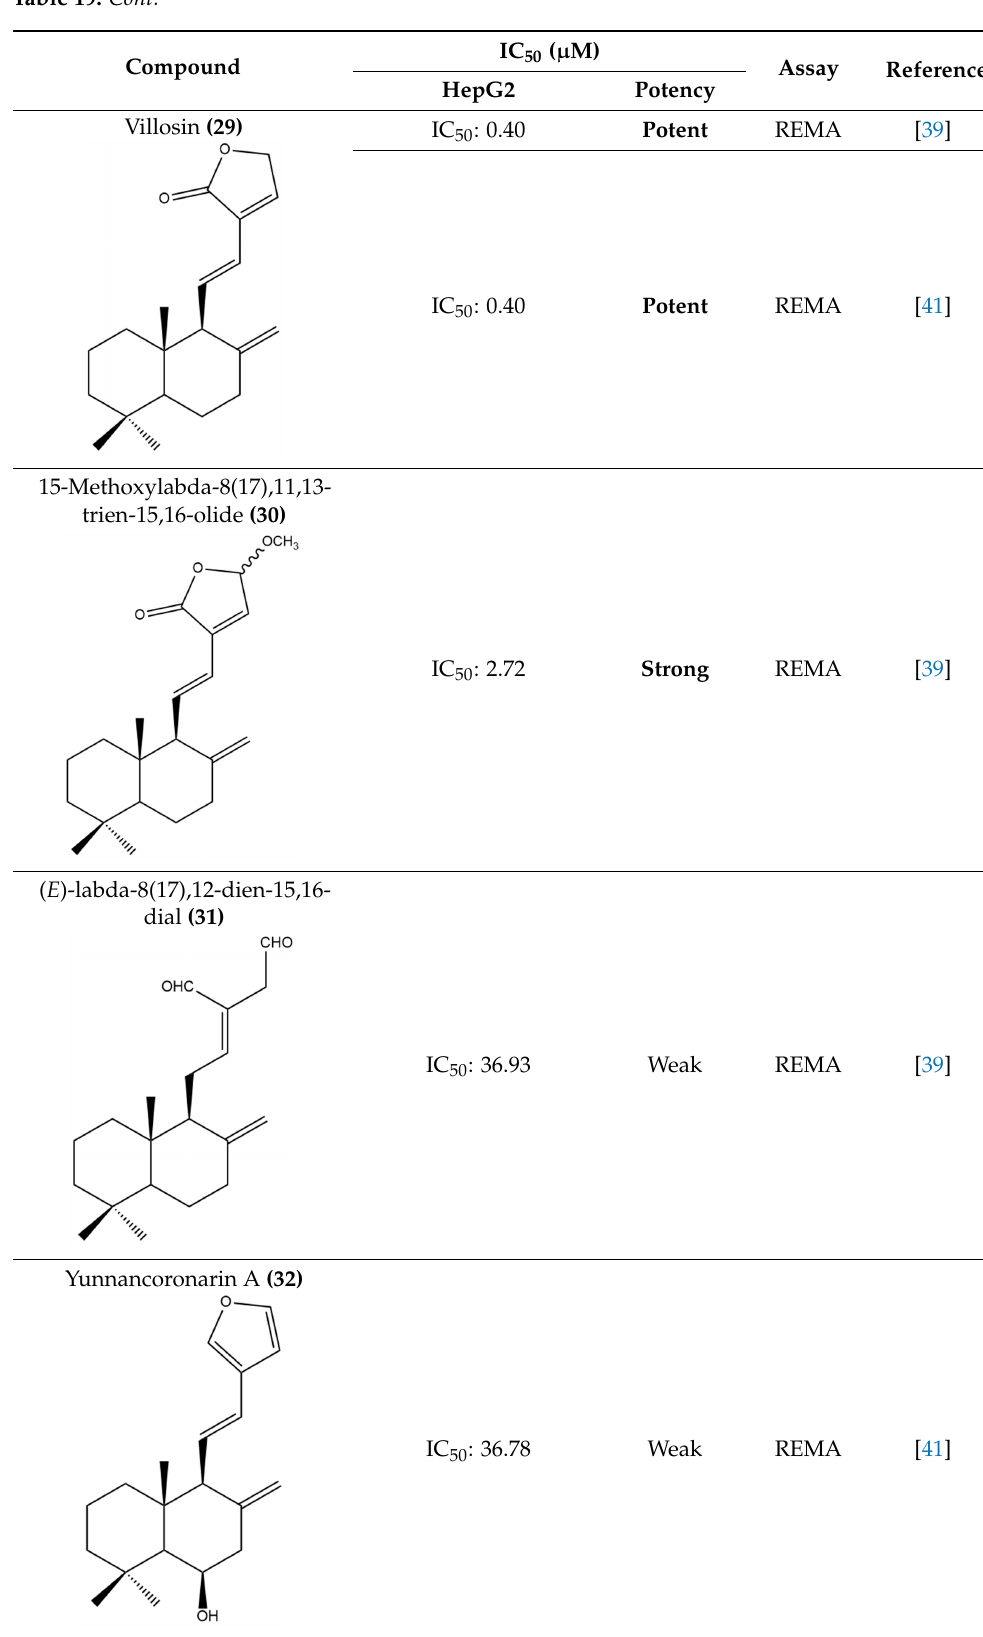
Table 19. Cont. Compound Assay